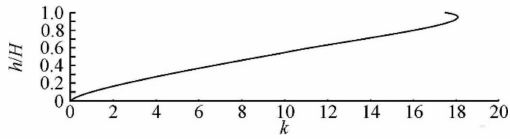
Figure 7. Relationship between the flow in an SCTT and the water filling ratio